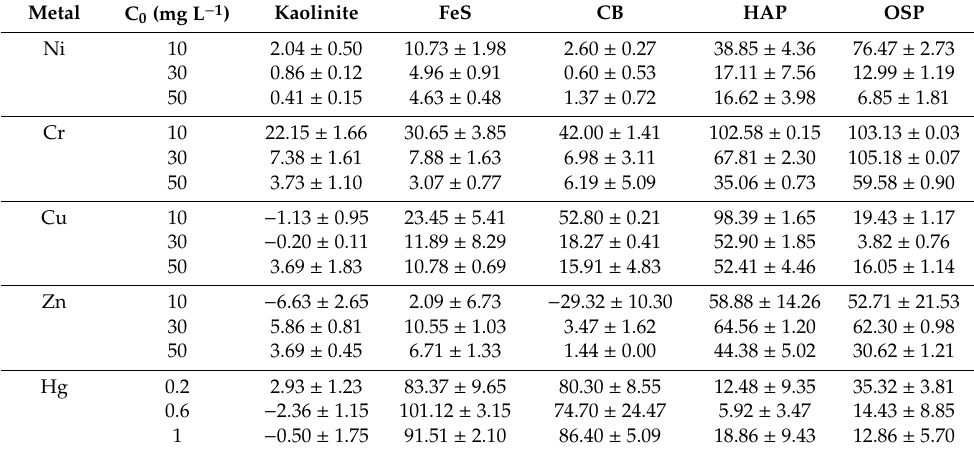
Table 3. Removal e ffi ciencies (in percentage) of five adsorbents for five metals ( n = 3).